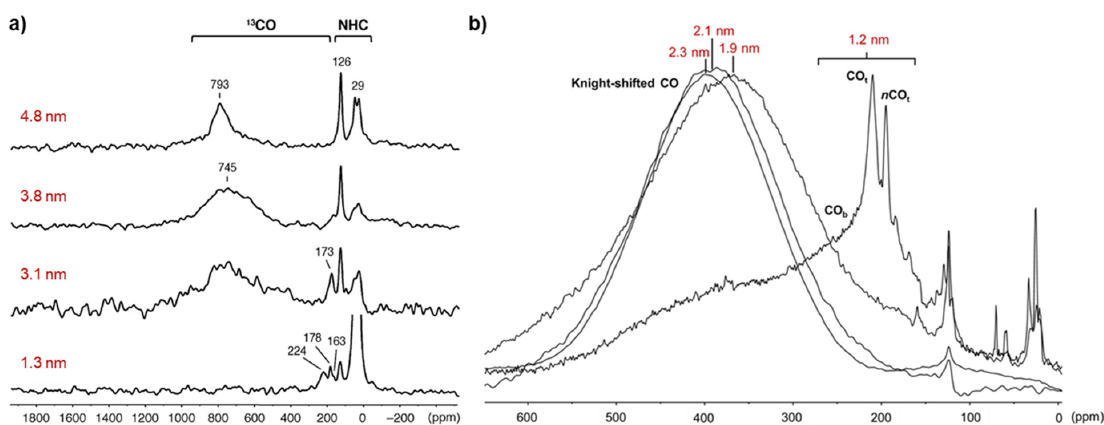
Figure 11. 13 C MAS-NMR spectra of ( a ) Pd and ( b ) Pt NPs with di ff erent sizes after exposure to Figure 11. 13 C MAS ‐ NMR spectra of ( a ) Pd and ( b ) Pt NPs with different sizes after exposure to 13 CO. 13 CO. Extracted from reference 57 and 70 with permission of Wiley-VCH and The Royal Society of Extracted from reference 57 and 70 with permission of Wiley ‐ VCH and The Royal Society of Chemistry, Chemistry, respectively.